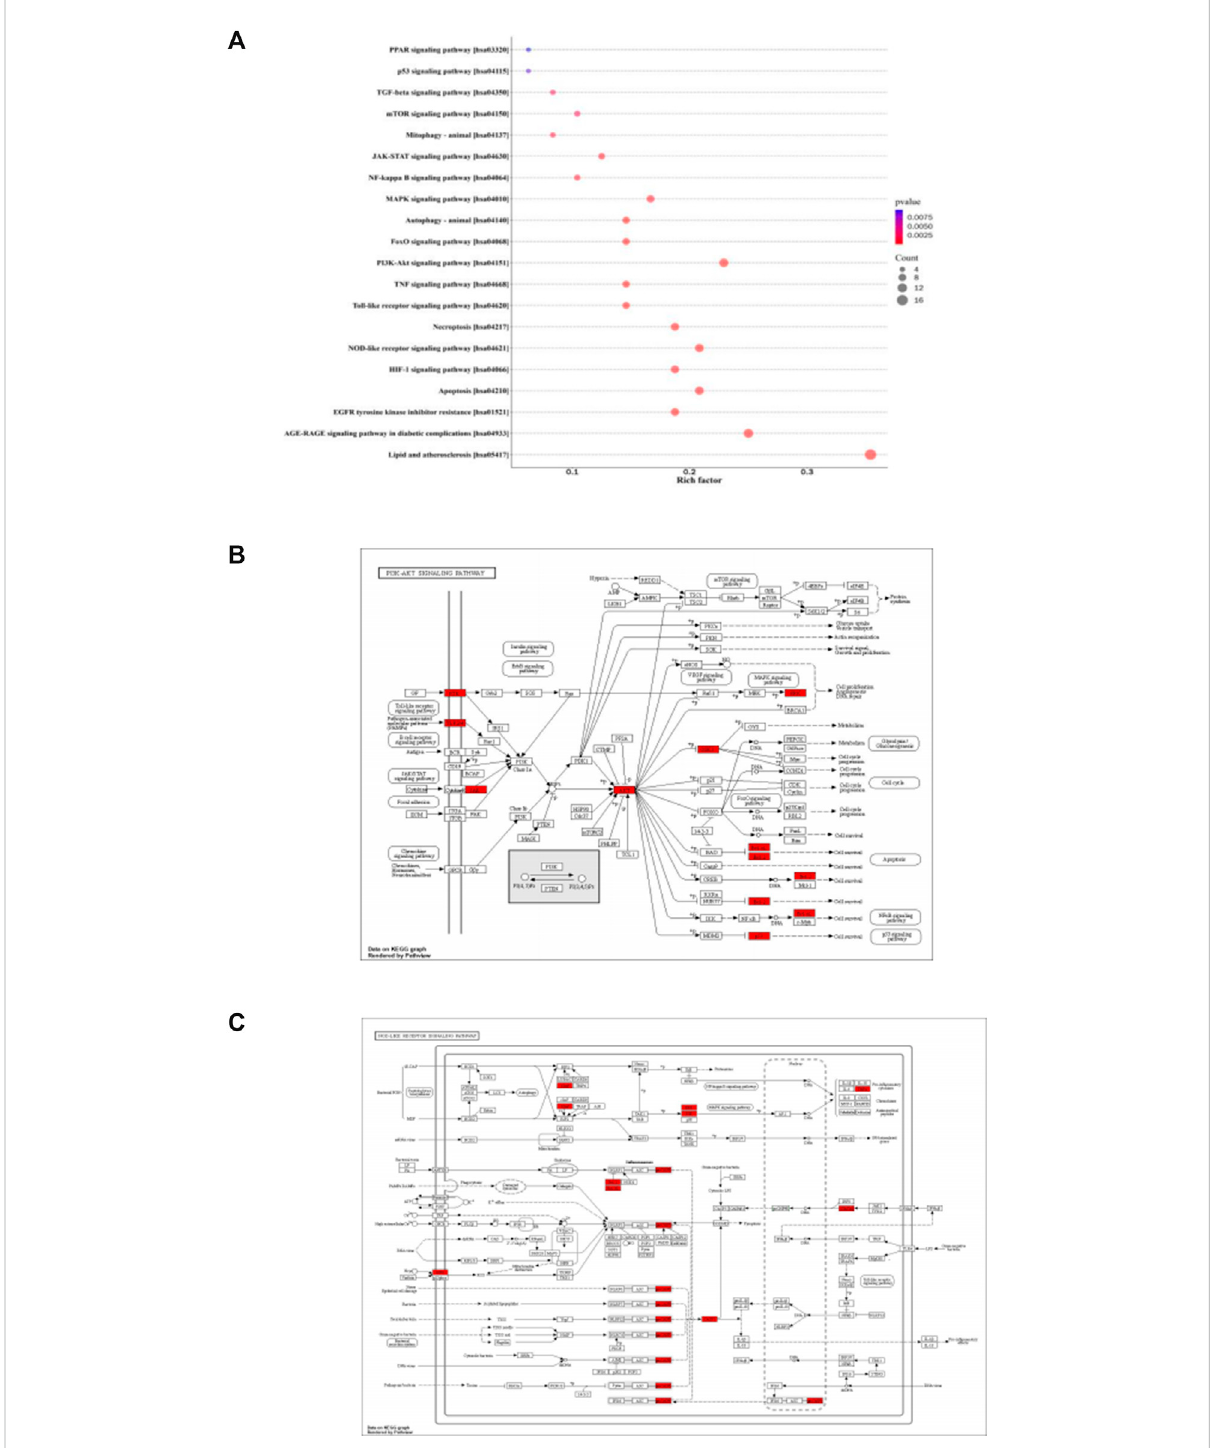
FIGURE 2 KEGG pathway enrichment analysis. (A) : The color of circles represented the p values, and the size of circles represented the count. (B) : The target proteins were marked bright red on the KEGG pathway map, PI3K-Akt signaling pathway. (C) : The target proteins were marked bright red on the KEGG pathway map, NOD-like receptor signaling